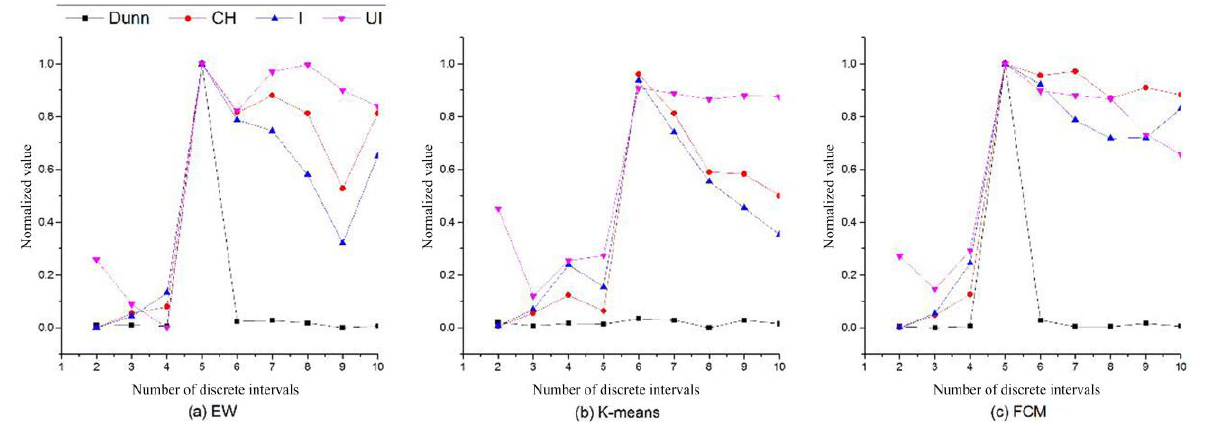
Figure 2. Evaluation of discrete effect of simulated